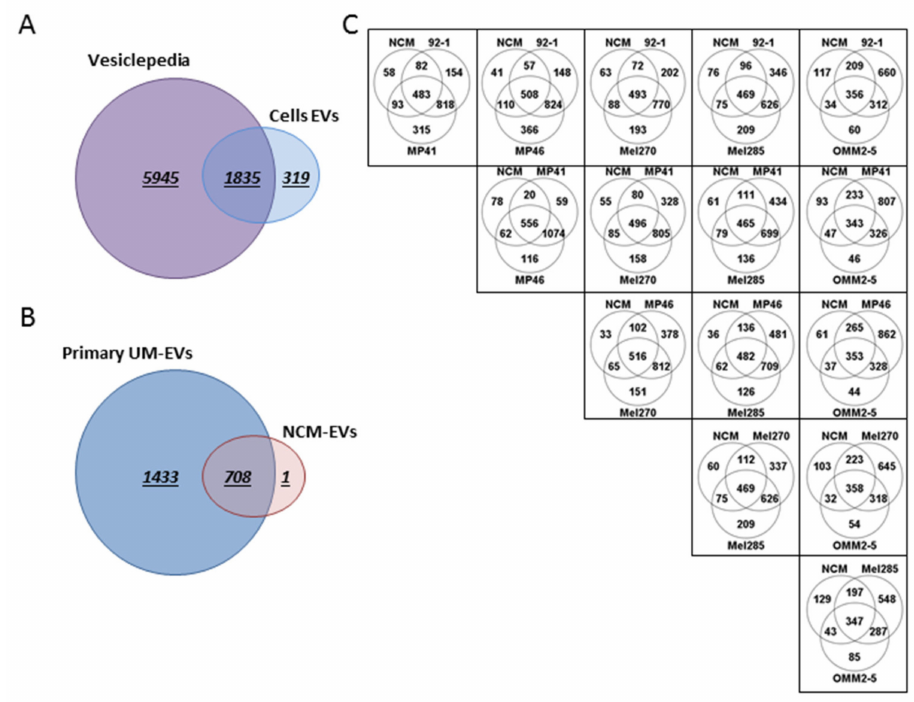
Figure 5. UM-EVs and NCM-EVs carried di ff erent sets of proteins. Venn diagram analyses. ( A ) The majority of proteins isolated from EVs derived from UM cells and NCMs were shared with data published in Vesiclepedia database. ( B ) NCM-EVs and primary UM-EVs shared 708 proteins, while 1 and 1433 proteins were exclusively present in NCM-EVs and primary UM-EVs, respectively. ( C ) Based ontheirproteincargo, primaryUM-EVsclustereddi ff erentlyfromNCM-EVs. Atotalof20to265proteins were exclusively shared between NCM-EVs and primary UM-EVs, while 287 to 1074 proteins were exclusively shared between EVs isolated from the di ff erent primary UM